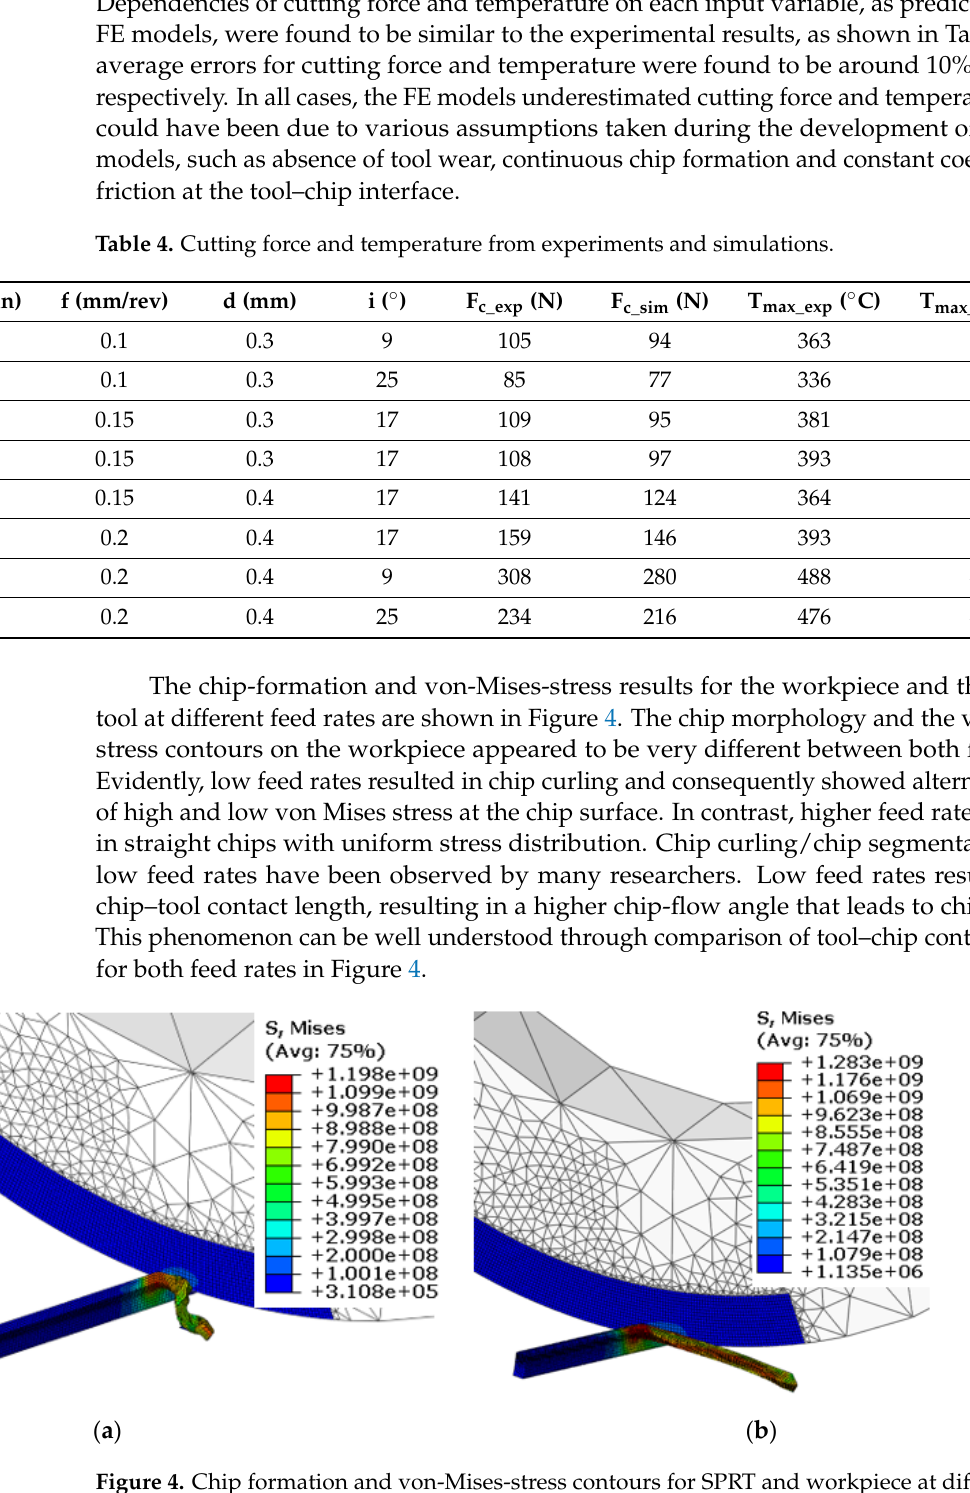
Figure 4. Chip formation and von-Mises-stress contours for SPRT and workpiece at different feed rates: ( a ) f = 0.1 mm/rev, ( b ) f = 0.2 mm/rev (V = 80 m/min, d = 0.3 mm and i = 17°).